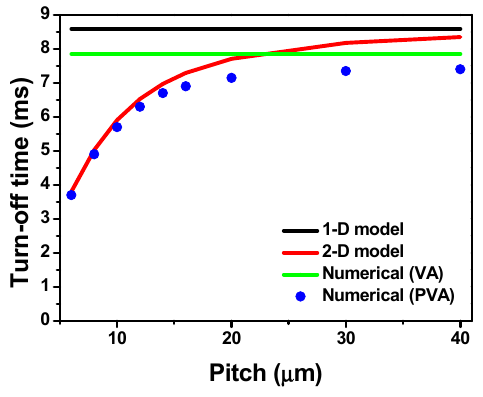
Figure 3. Turn-off times of PVA cells obtained using a 1D model, 2D model, and numerical calculation as a function of patterned electrodes pitch.